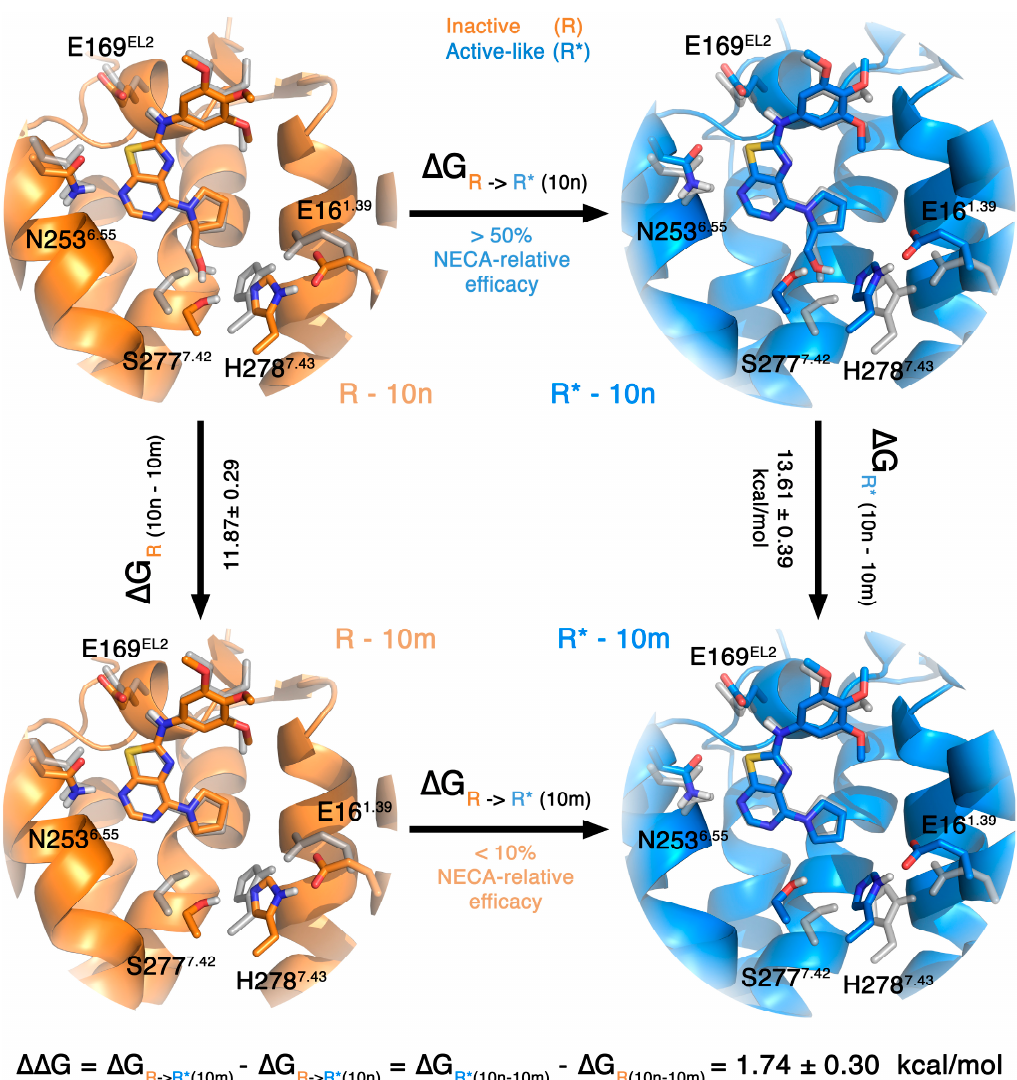
Figure 2. Thermodynamic cycle showing the relationship between the potency of the ligand pair 10m / 10n and the relative free energies of perturbing 10n to 10m in the active-like (blue) and inactive (orange) structures. The grey sticks represent the conformation of the residues in the active-like structure as compared to the inactive structure, and vice versa. A ligand that activates the receptor (partial or full agonist) should in theory have a higher affinity for the active state of that receptor. Thus, perturbing the (partial) agonist ( 10n ) into an antagonist ( 10m ) should result in an unfavorable change in binding free energies, as shown here for the 10n → 10m transformation.